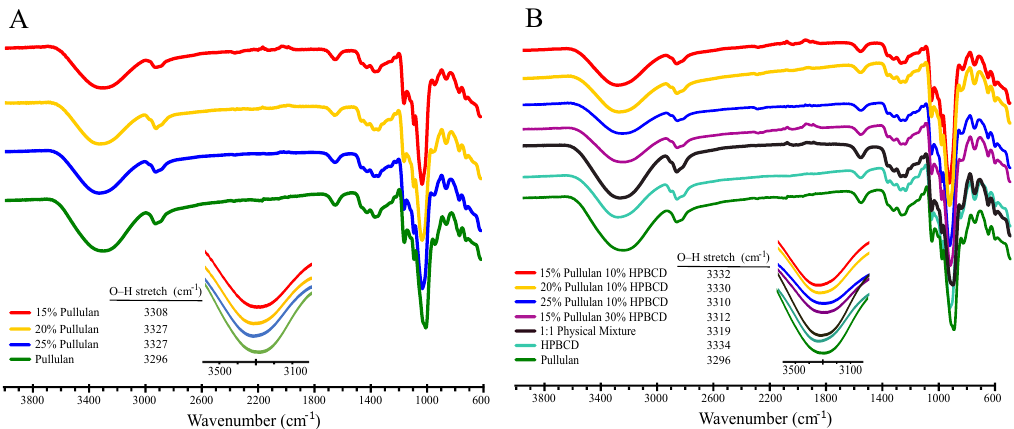
Figure 9. FTIR spectra of ( A ) pure pullulan and pullulan electrospun fibers, and ( B ) pure pullulan, HP- β -CDandpullulan / HP- β -CDphysicalmixture, andelectrospunfibersofvaryingpullulan: HP- β -CD content. Traces have been normalized to the intensity of their strongest peak and shifted vertically for clarity. An inset is included to highlight peak shifts for the hydroxyl groups (O–H)